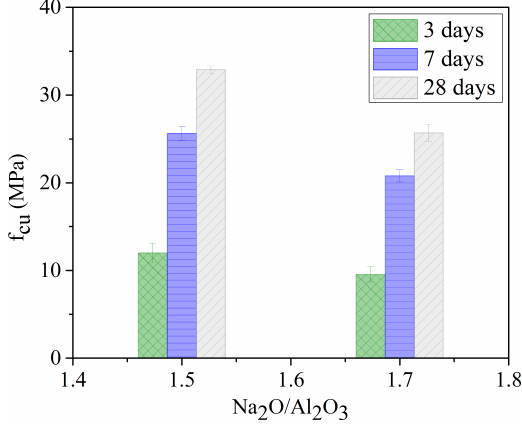
Figure 8: Effect of N/A molar ratio on compressive strength